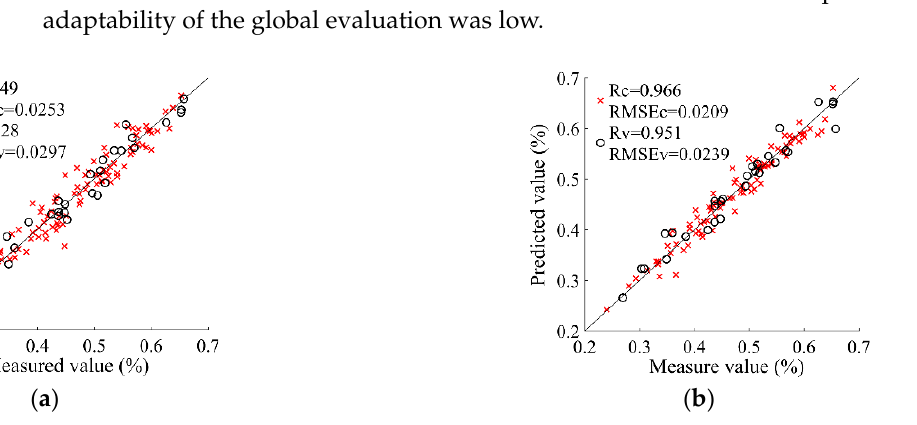
( b ) Figure 5. Optimization of SVR parameters. ( a ) SPA; ( b ) MCUVE. The evaluation of SCC based on SPA-POS-SVR is shown in Figure 6a. The correlation coefficients of the Cs and Vs were 0.949 and 0.928, respectively, and the RMSEs of both sets were 0.0253% and 0.0297%, respectively. The evaluation ability in the SCC range of 0.2000 – 0.4000% and 0.6000 – 0.7000% was better than that in the SCC range of 0.4000 –